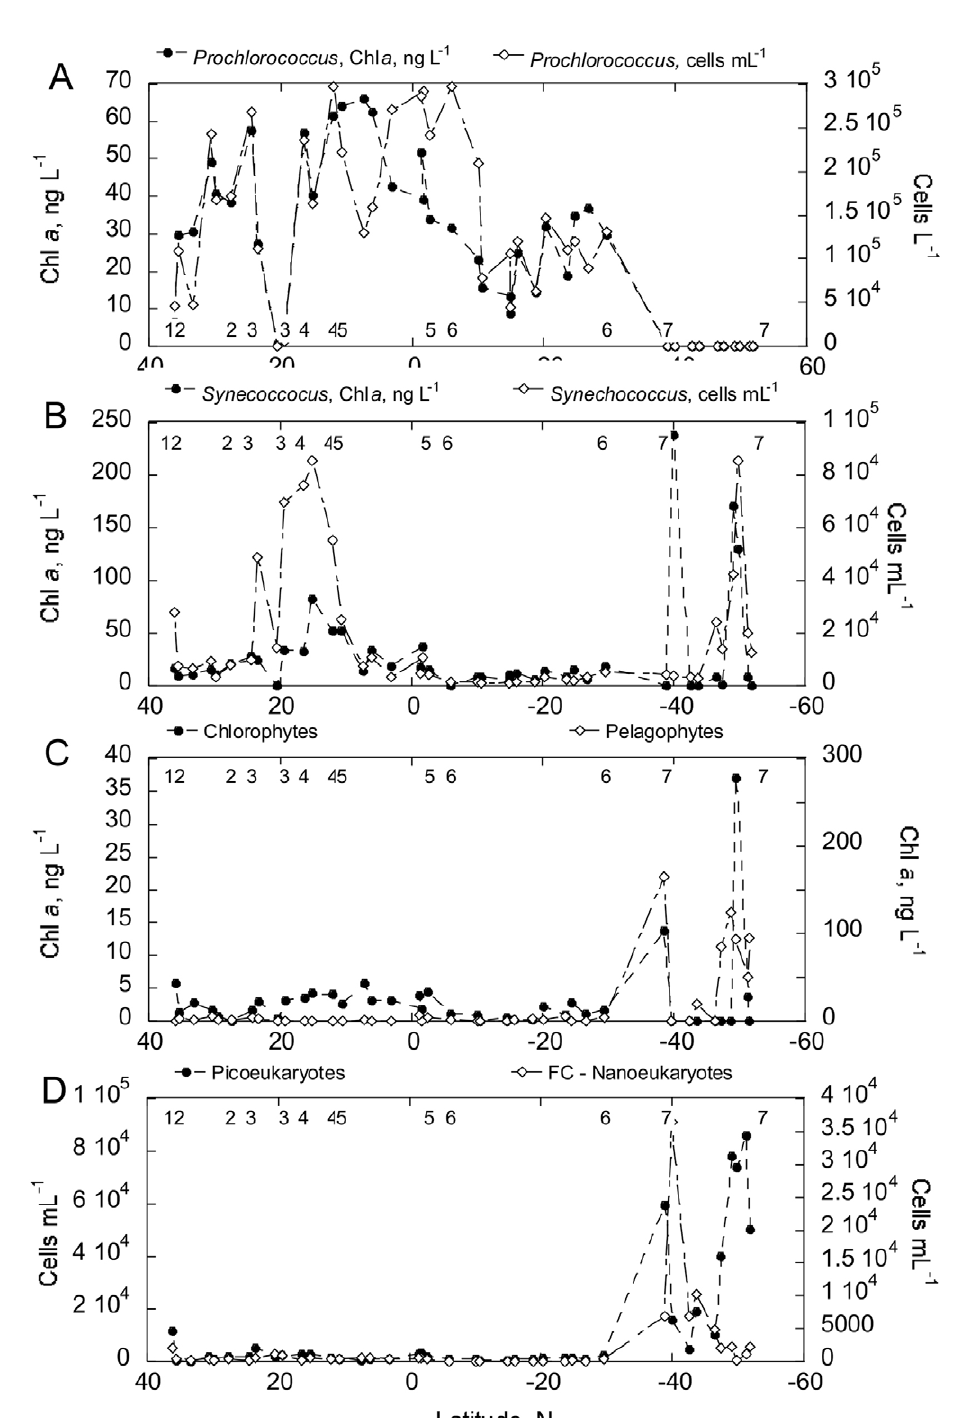
Fig. 5. – Latitudinal variation of CHEMTAX-derived Chl a (ng L –1 ) and cell counts (cells L –1 ) for Prochlorococcus (A) and Synechococcus (B); C, latitudinal variation of CHEMTAX-derived Chl a (ng L –1 ) for chlorophytes (left ordinate scale) and pelagophytes (right ordinate scale); and flow cytometric counts (cells ml –1 ) of autotrophic picoeukaryotes (left ordinate scale) and nanoeukaryotes (right ordinate scale)